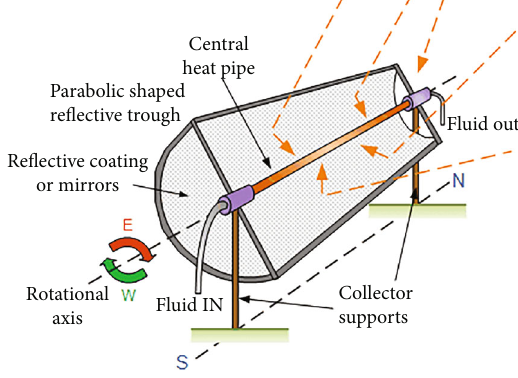
Figure 2: Sunlight and its re fl ection [9]. Table 1: Model validation with thermal e ffi ciency. Length of